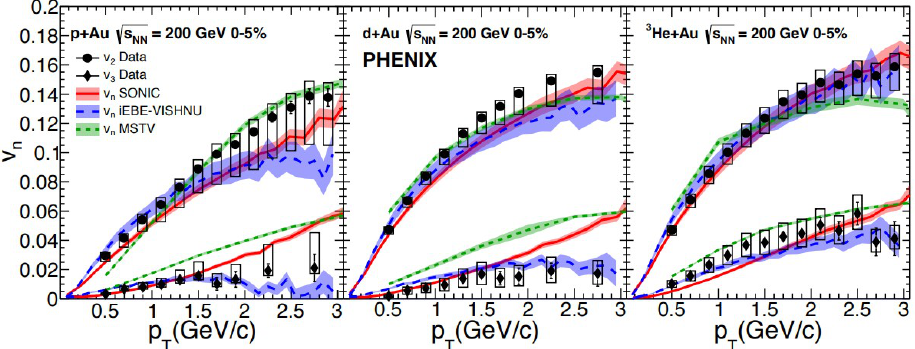
Figure 5. Elliptic (v 2 ) and triangular (v 3 ) flows measured for charged hadrons in 0-5% most central p/d/ 3 He + Au collisions at  s NN = 200 GeV compared to different model